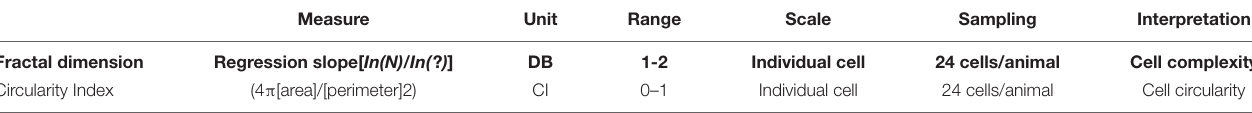
TABLE 1 | Summary of microglia/macrophage morphology